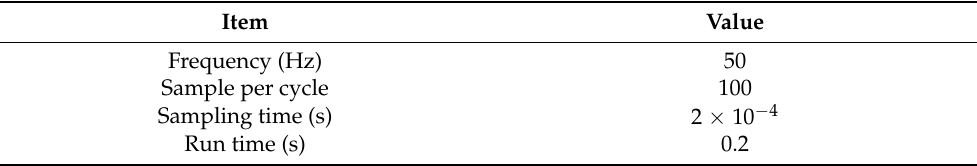
Table 1. Simulink parameters for the test system